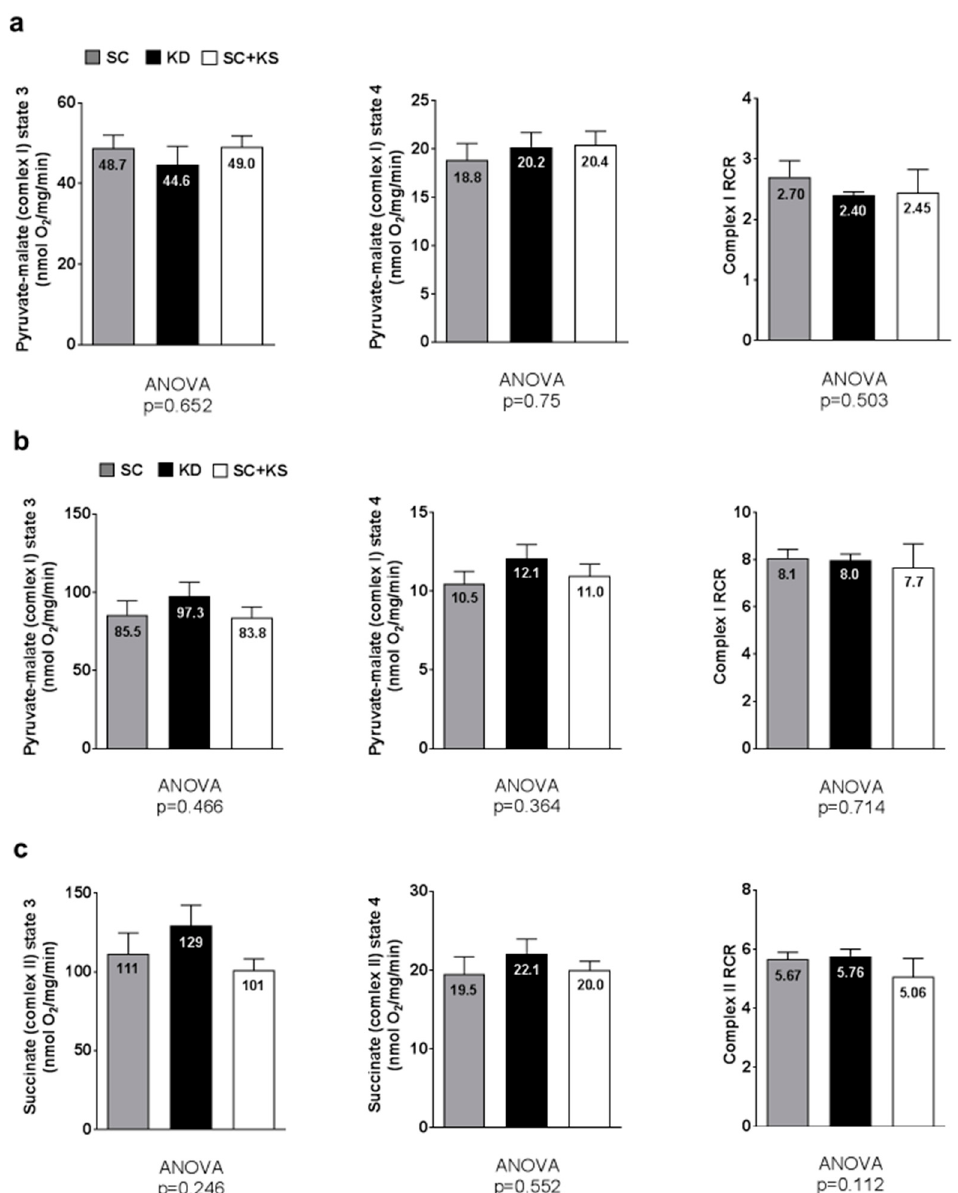
Figure 10. Brain and liver mitochondrial function in 8 month-fed rats. Legend: Brain state 3 and 4 pyruvate-malate and respiratory control ratio (RCR) values are presented in panel ( a ); Liver state 3 and 4 pyruvate-malate and RCR values are presented in panel ( b ); Liver state 3 and 4 succinate and RCR values are presented in panel ( c ). All bars are presented as mean ± standard error values ( n = 7–8 per group), group means are indicated within each bar and ANOVA p -values are presented below data. Abbreviations: SC, standard chow-fed rats; KD, ketogenic diet-fed rats; SC + KS, standard chow-fed rats with supplemental sodium beta-hydroxybutyrate; RCR, respiratory exchange